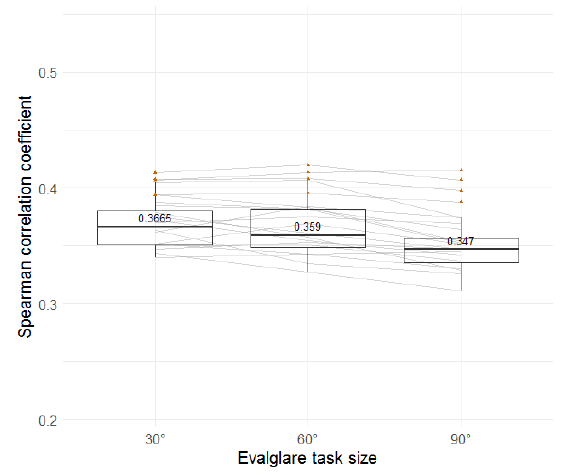
Figure 24. Boxplots of Spearman rho for the three task area sizes (field study).